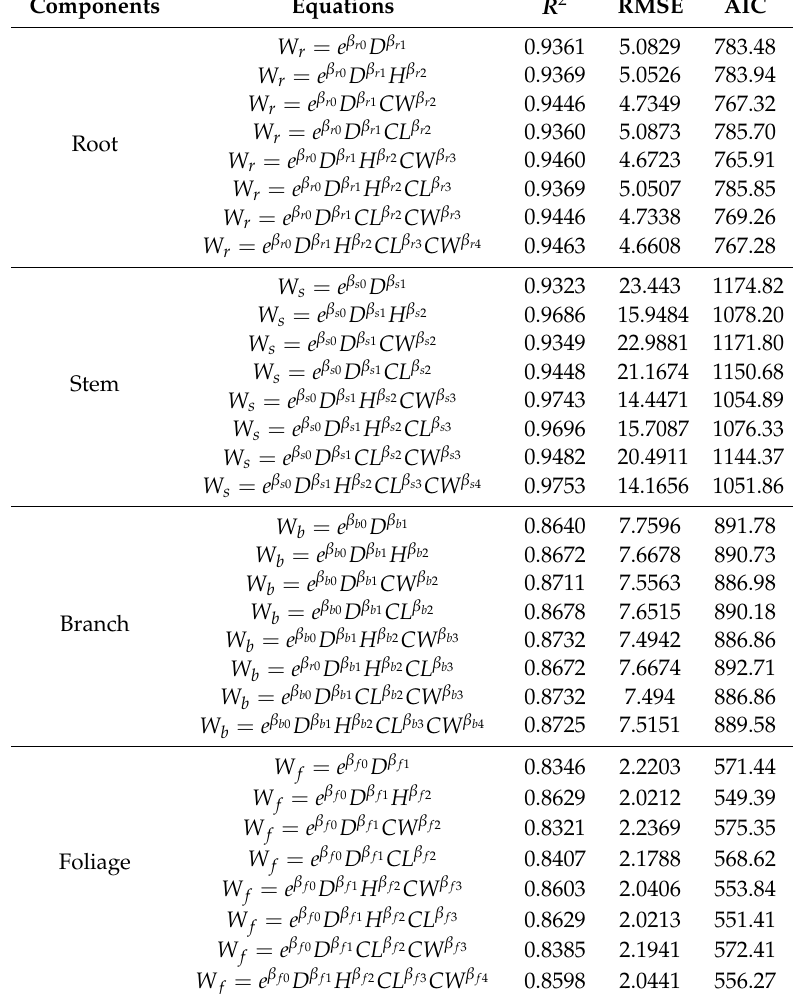
Table 2. Fit statistics of the eight biomass models based on several combinations of di ff erent predictors for each tree component of Populus × xiaohei